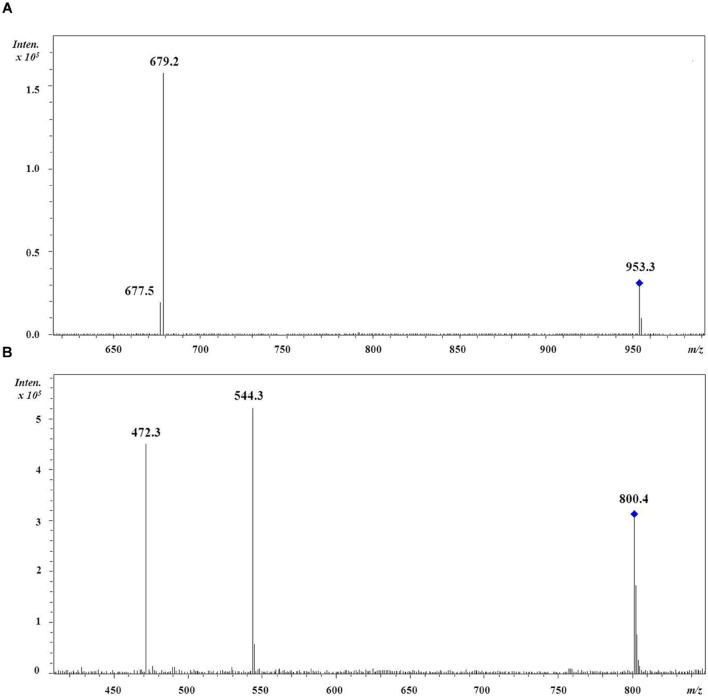
Positive-ion MS/MS spectra of (A) DGDG (18:5/18:4). The fragment at m/z 679 represents the loss of the sn-1 linked acyl chain 18:5 whilst the fragment at m/z 677 represents the loss of the sn-2 linked acyl chain 18:4; (B) DGCC (16:0/22:6). The fragment at m/z 544 represents the loss of the acyl chain 16:0 while the fragment at m/z 472 represents the loss of the acyl chain 22:6 but no information about their regiochemical distribution is implied.